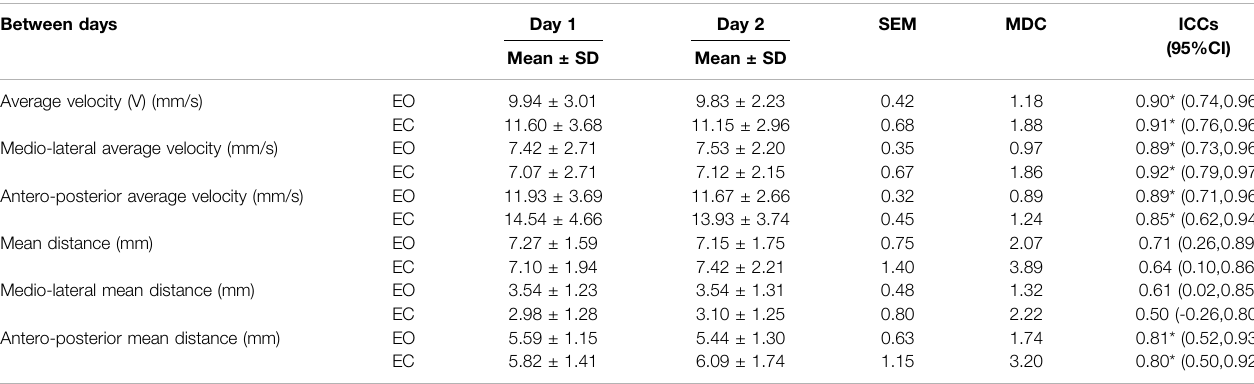
TABLE 2 | Between-days reliability for different COP variables in young participants. Between